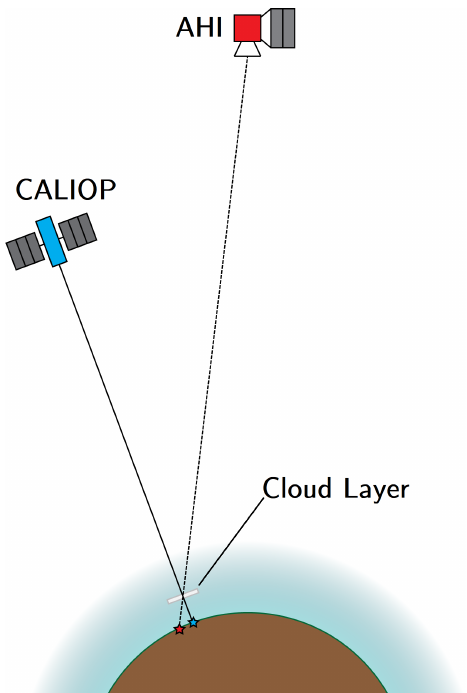
Figure 2. The difference in observation angles between CALIOP (blue) and AHI (red) for a layer (grey) at some altitude above the surface of the Earth (brown). At more extreme observation angles for AHI, i.e. towards the edge of the FOV, large differences in the apparent location of the layer can occur. For example, if the eleva- tion angle of AHI from the layer is 45 ◦ at an altitude of 10km, the location of the layer is shifted by 10km, approximately the equiva- lent of five pixels at 2km